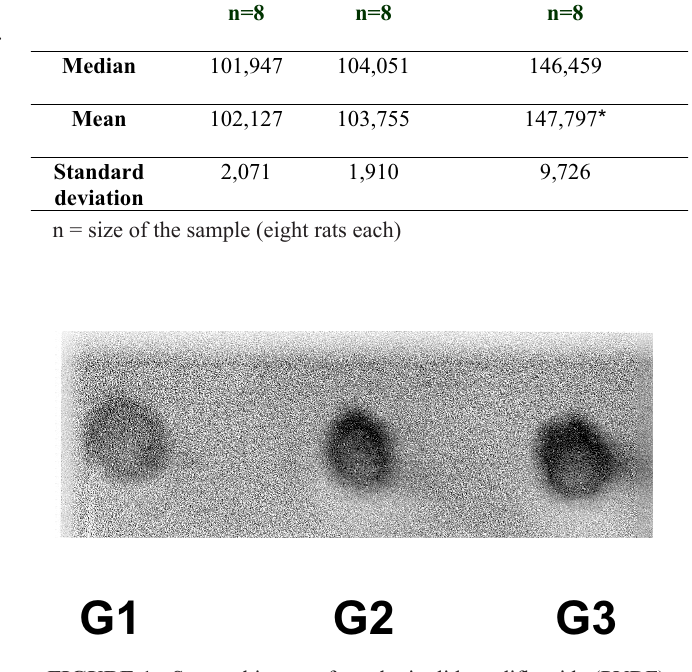
TABLE 1 - Individual results (optical density) of each group Control